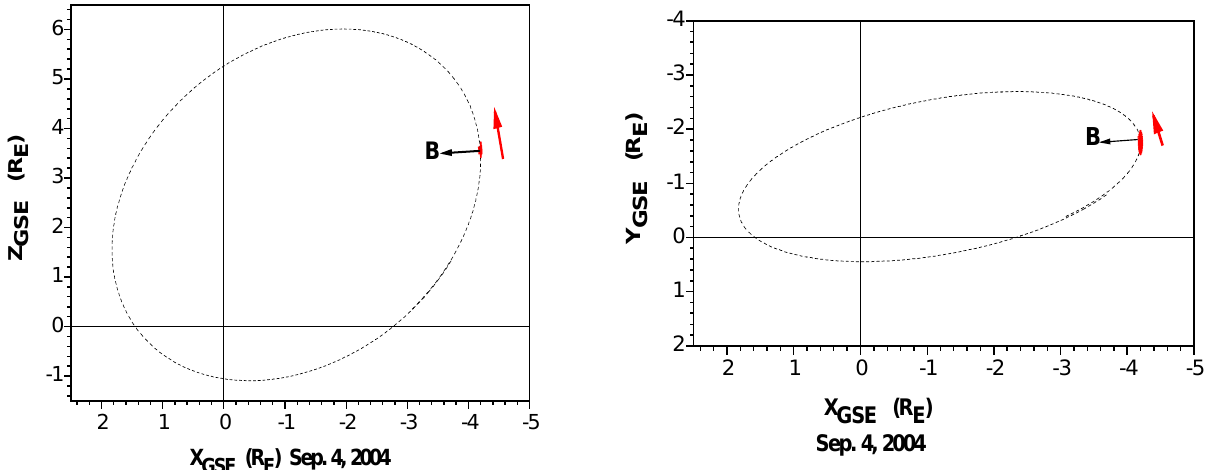
Fig. 7.The location of TC-2 in the Z-X plane (left panel) and in the Y-X plane (right panel) in the GSE system. Dotted lines indicate the orbit of the spacecraft. The red heavy line shows the position of the spacecraft when the frames displayed in Fig. 6 were recorded. Black arrows indicate the magnetic field direction and red arrows the direction of motion of the spacecraft at that time.